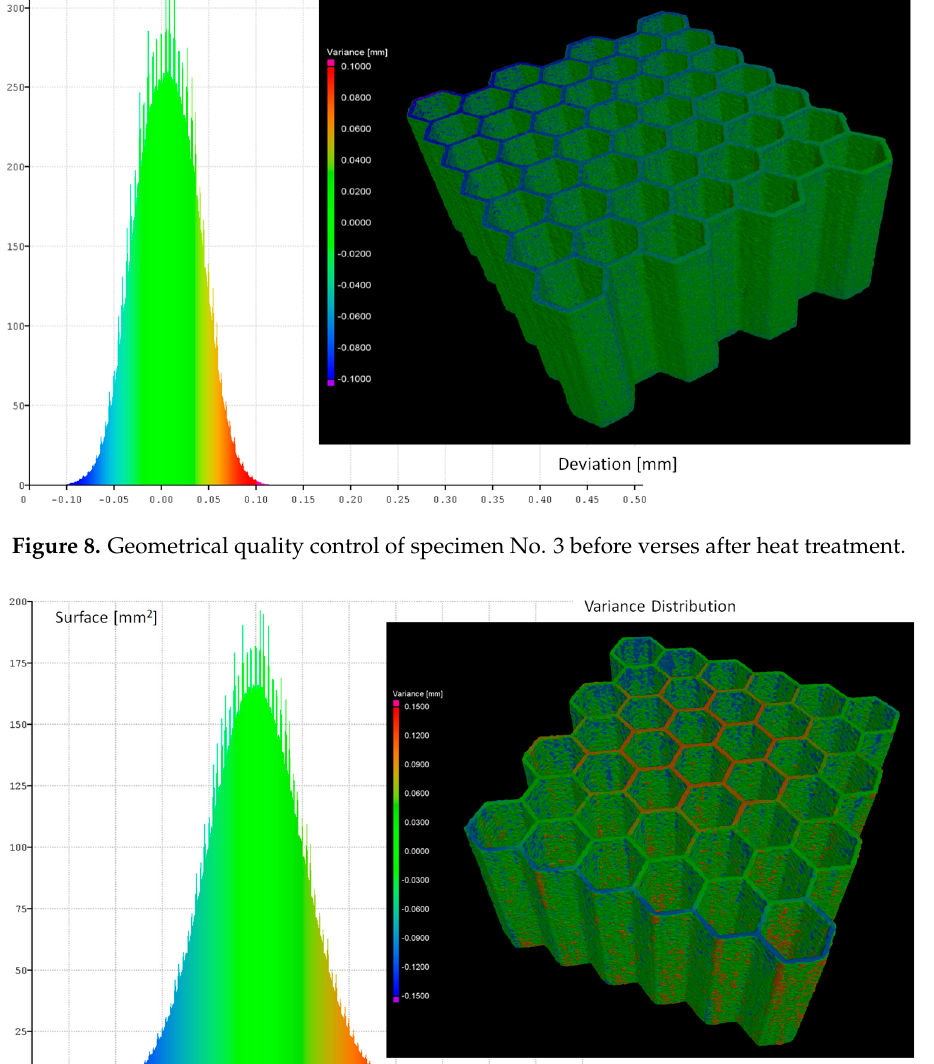
Figure 7. Geometrical quality control of specimen No. 2 before versus after heat treatment.